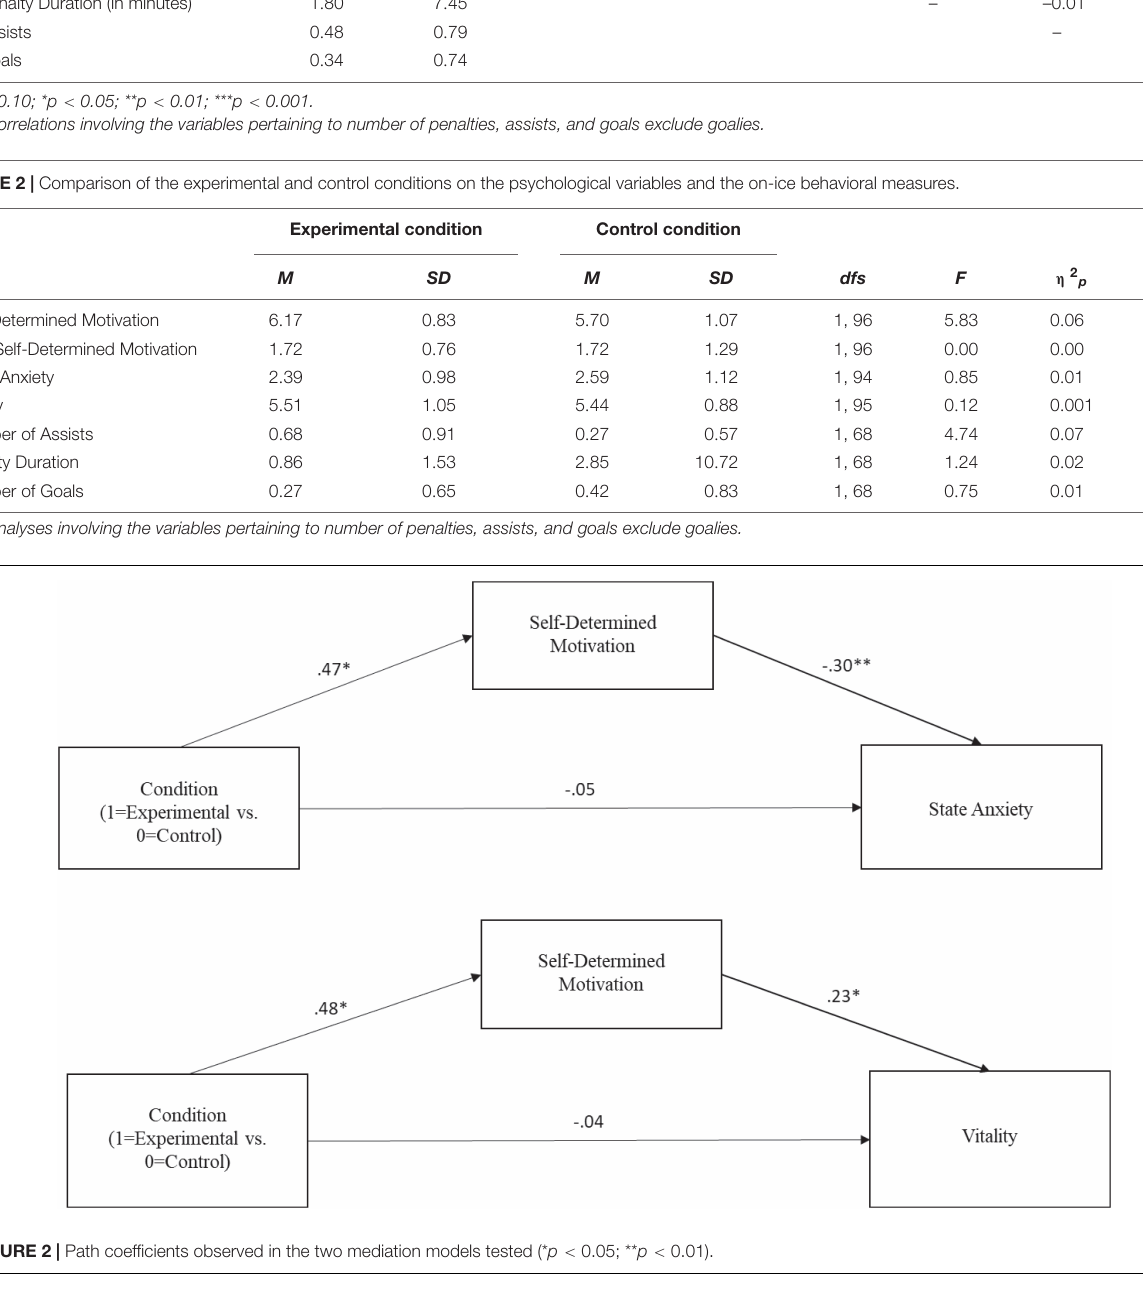
A field-based experimental design was employed. Specifically, participants were randomly assigned either to an experimental condition, which presented actual and increasingly